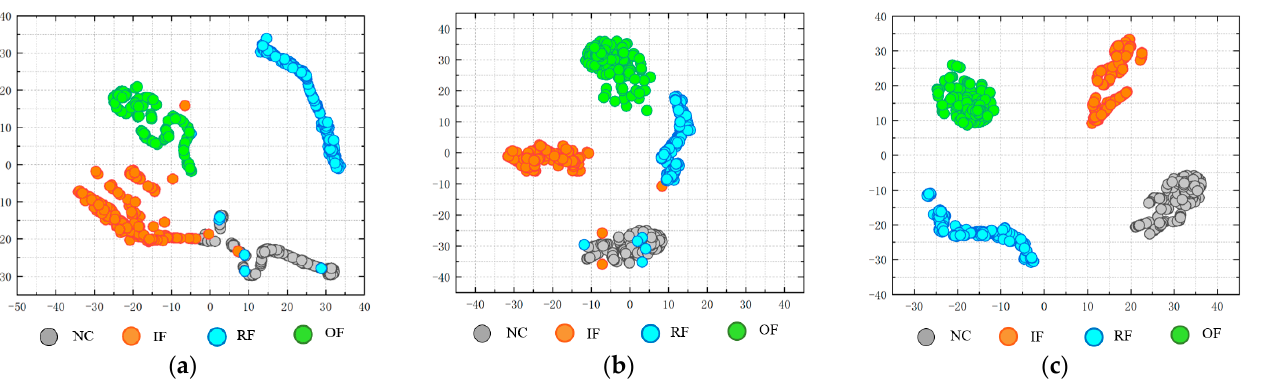
Figure 11. Dimensionality reduction visualization results on Dataset A: ( a ) GAN, ( b ) WGAN. ( c ) WGAN-GN.